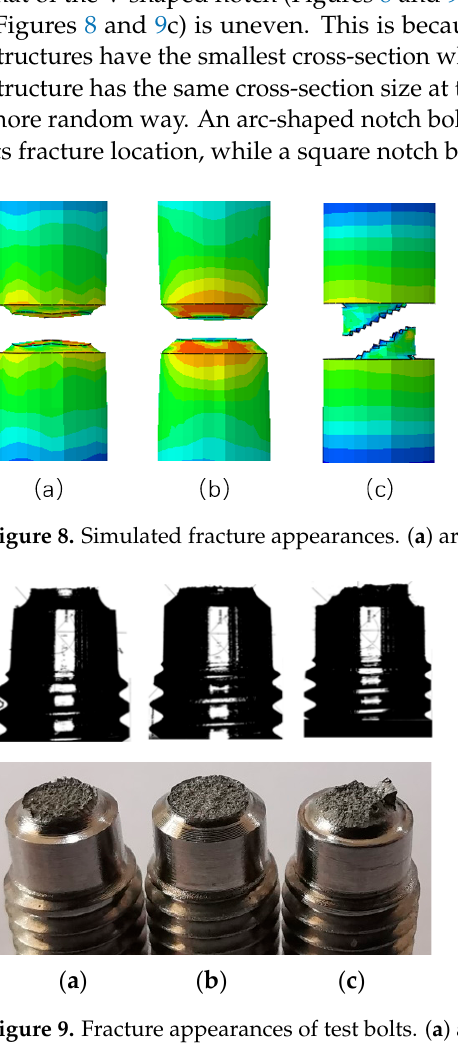
Figure 9. Fracture appearances of test bolts. ( a ) arc-shaped; ( b ) V-shaped; ( c ) square notch. In summary, it is concluded that the arc-shaped notch structure can not only greatly improve the tensile and shear loads of the bolt but also accurately control its fracture lo- cation. Therefore, the arc-shaped structure is the optimal notch structure.